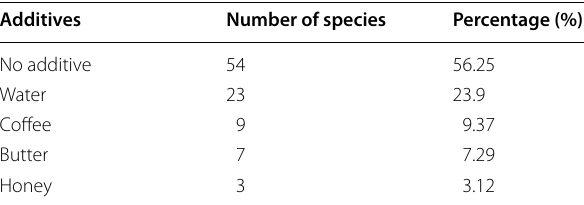
Table 2 Additives or solvents used for human remedial preparations in Artuma Fursi